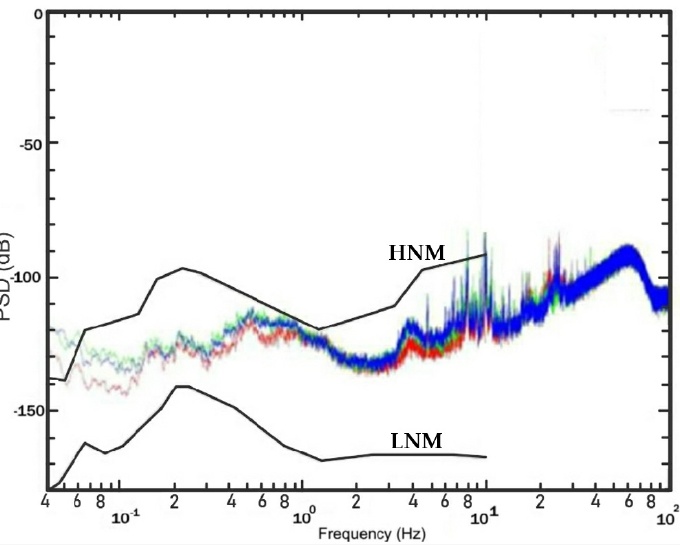
Figure 2. PSD of the seismic noise recorded by an OBS/H on 20 July 2006; 20–60 Hz peaks are well visible (redrawn from [52]). The two lines, HNM (high noise model) and LNM (low noise model), are according to [54].